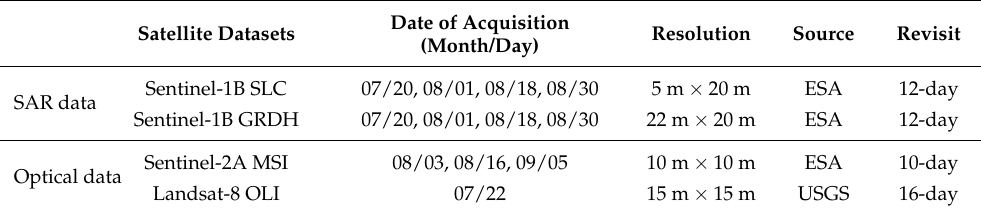
Table 1. List of satellite data parameters in this